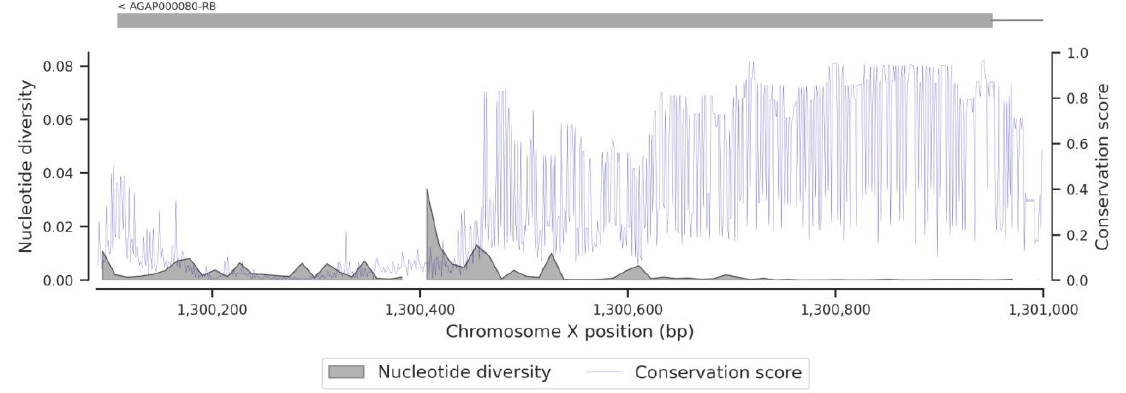
Figure A7. Conservation score and nucleotide diversity in a window of 12 bp within the zinc-finger A (ZnFA) region of the Fruitless gene; upper figure shows the ZnFA region (the rectangle corresponds to the exonic region, and the simple line is the intronic region); lower figure shows the conservation score (blue line) and the nucleotide diversity (dark fill) plot.